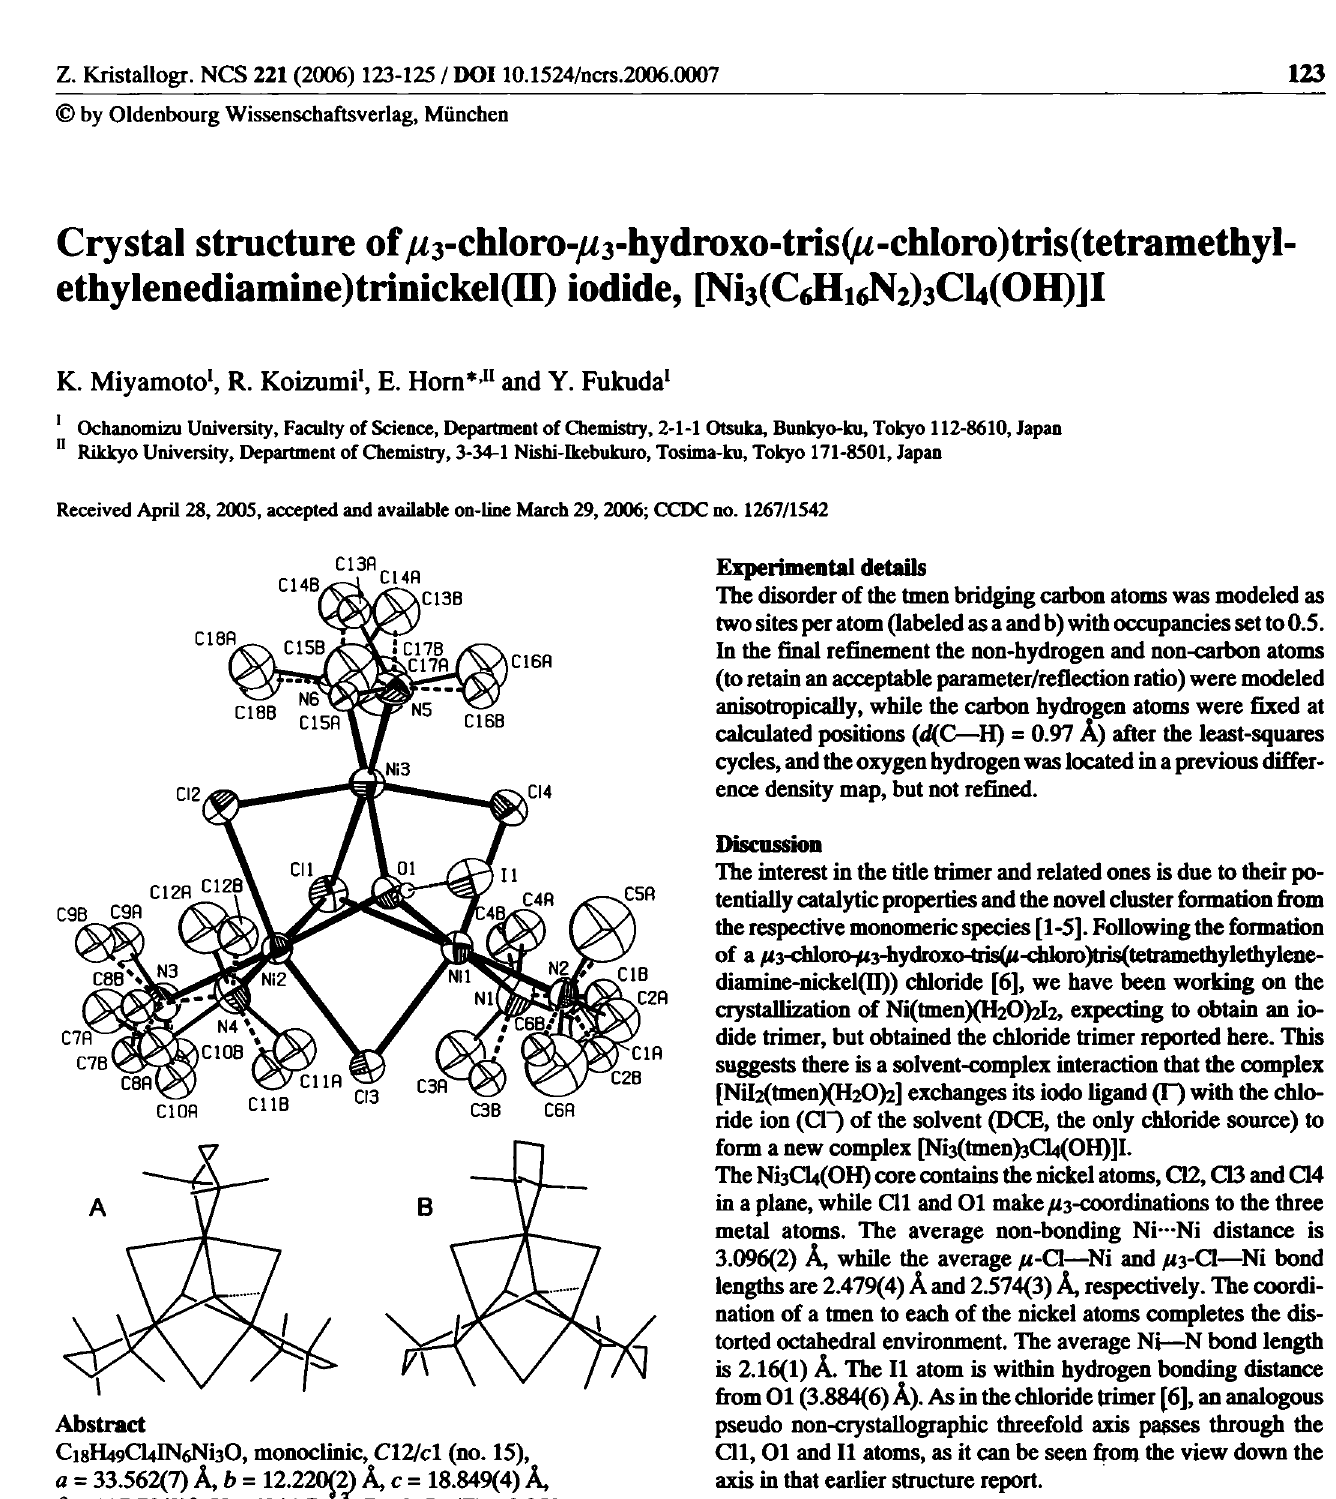
Table 1. Data collection and